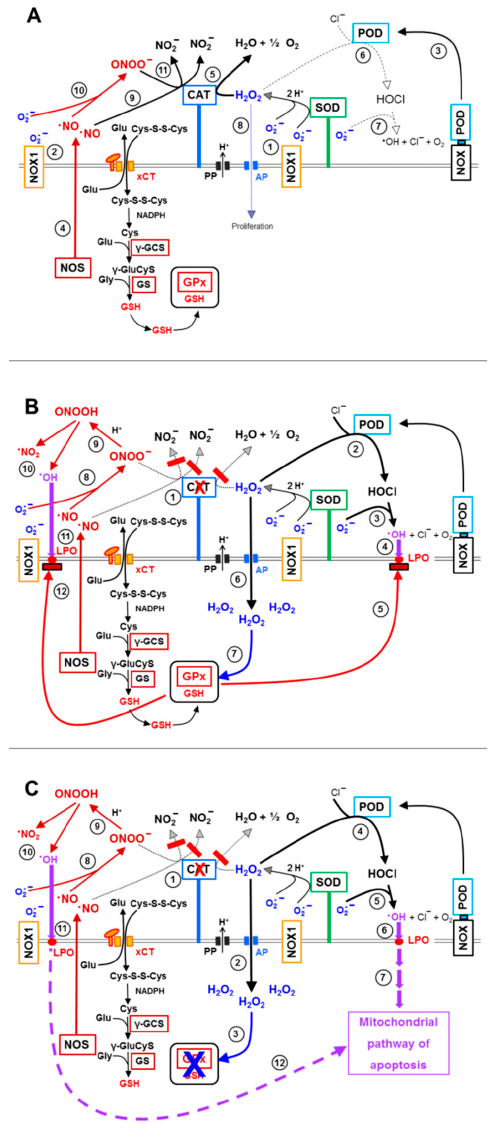
Figure 16. NO/peroxynitrite and HOCl signal interact with aquaporins. ( A ): Catalase protects towards ROS/RNS signaling. Superoxide anions generated by NOX1 are the basis for HOCl signaling (#1), as they lead to the formation of H 2 O 2 , and also for NO/peroxynitrite signaling (#2), as they are reaction partners for NO. HOCl signaling requires the presence of POD (#3), whereas NO/peroxynitrite signaling is determined by NOS-derived NO (#4). Membrane-associated catalase prevents HOCl signaling through decomposition of H 2 O 2 (#5–7). As a consequence of H 2 O 2 decomposition, the influx of H 2 O 2 through aquaporins is minimal (#8). Catalase also prevents NO/peroxynitrite signaling, as it oxidizes NO (#9) in a two-step reaction that requires compound I of catalase, and as it decomposes peroxnitrite (#10). ( B ): Consequences of catalase inhibition. The inhibition of catalase (#1) reactivates HOCl signaling (#2–4), but the resultant lipid peroxidation (LPO) first remains without effects as it is efficiently repaired by GSH/GPx (#5), as long as the influx of H 2 O 2 through aquaporins (#6, 7) has not achieved glutathione depletion. Inhibition of catalase abrogates oxidation of NO and decomposition of peroxynitrite and therefore reactivates NO/peroxynitrite signaling (#8–11). The resultant lipid peroxidation is blocked by GSH/GPx as well (#12). ( C ) Final steps. As a consequence of catalase inhibition (#1), H 2 O 2 influx through aquaporins (#2) finally leads to the depletion of GSH (#3) and renders the complex GPx/GSH nonfunctional. Therefore, HOCl signaling (#4–6) and NO/peroxynitrite signaling (#8–11) are no longer counteracted by GPX/GSG and induce the mitochondrial pathway of apoptosis (#7, #10). Importantly, NO/peroxynitrite signaling and HOCl signaling act sequentially, but not in concert, due to complex consumption reactions between NO and H 2 O 2